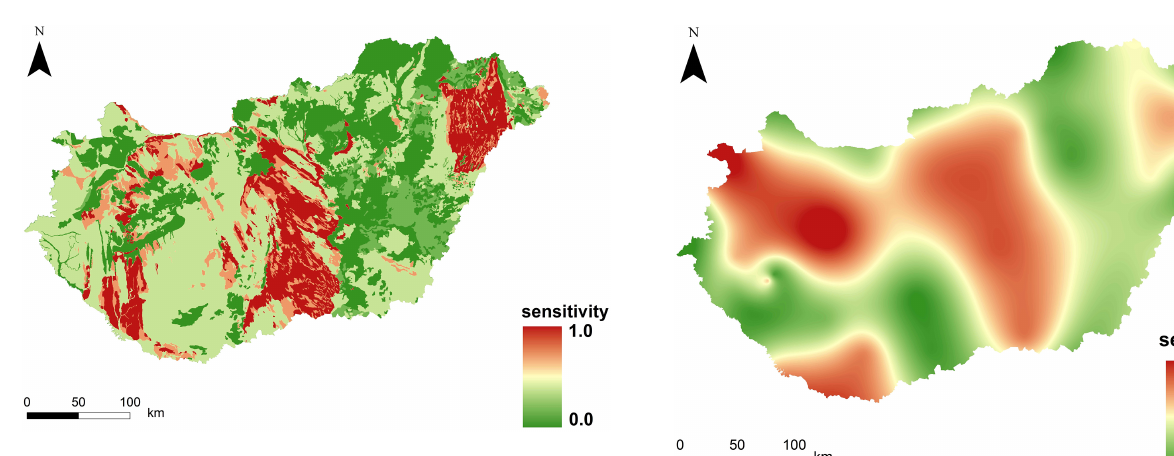
Figure 10. Sensitivity of soil texture to wind erosion based on soil erodibility index.